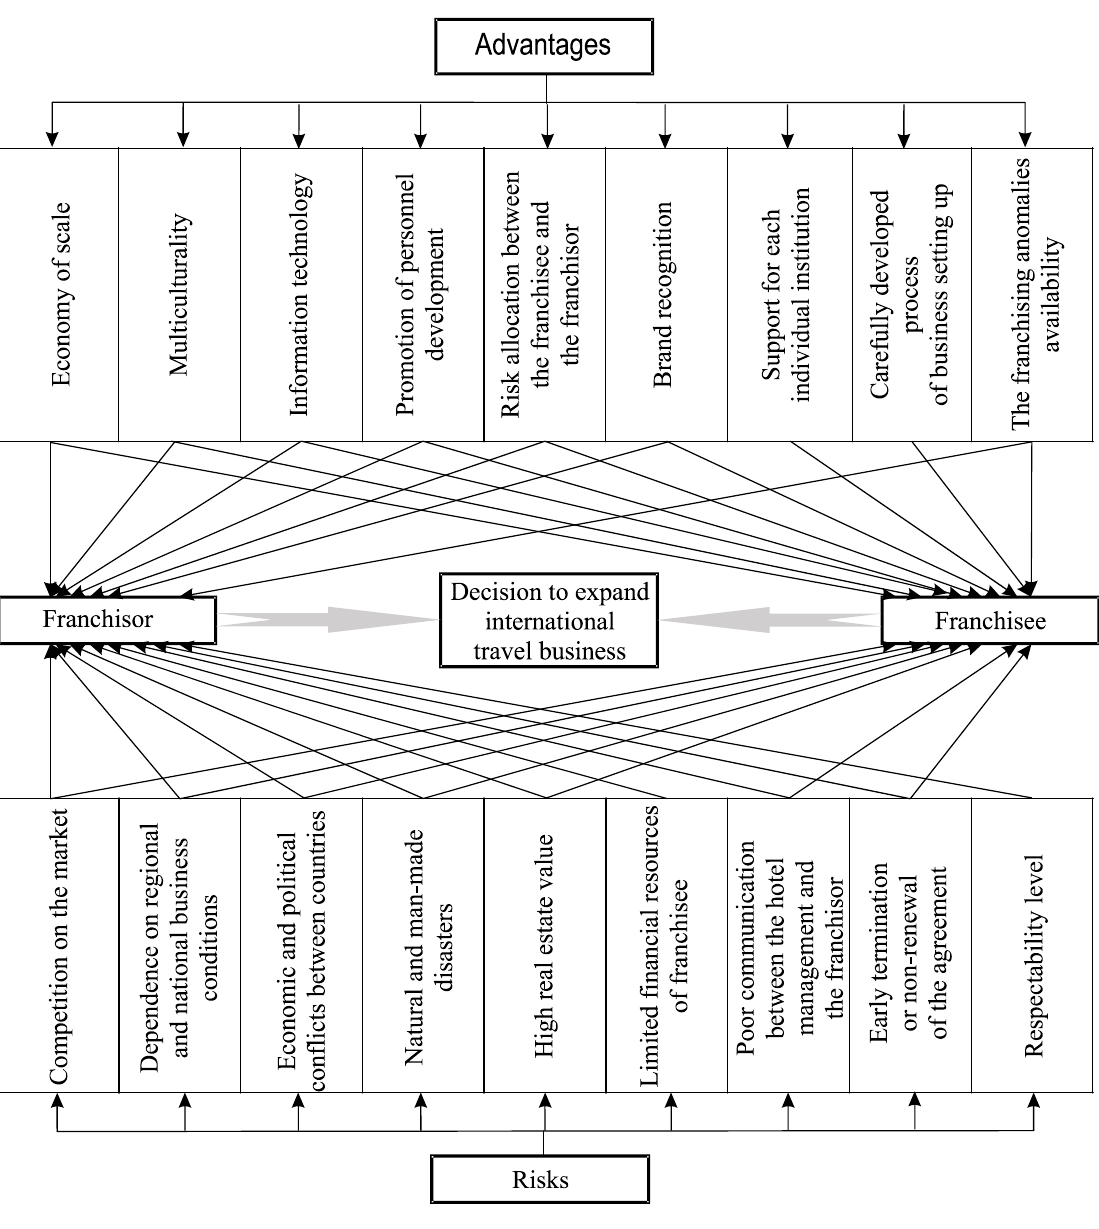
Figure 6. Franchising model for deciding about the international travel business